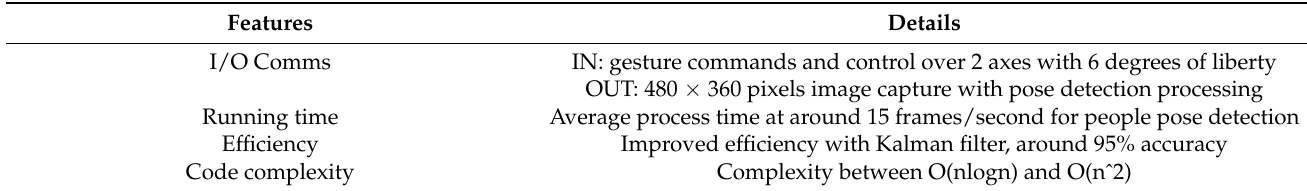
Table 7. The complexity overview for the Drone UAV